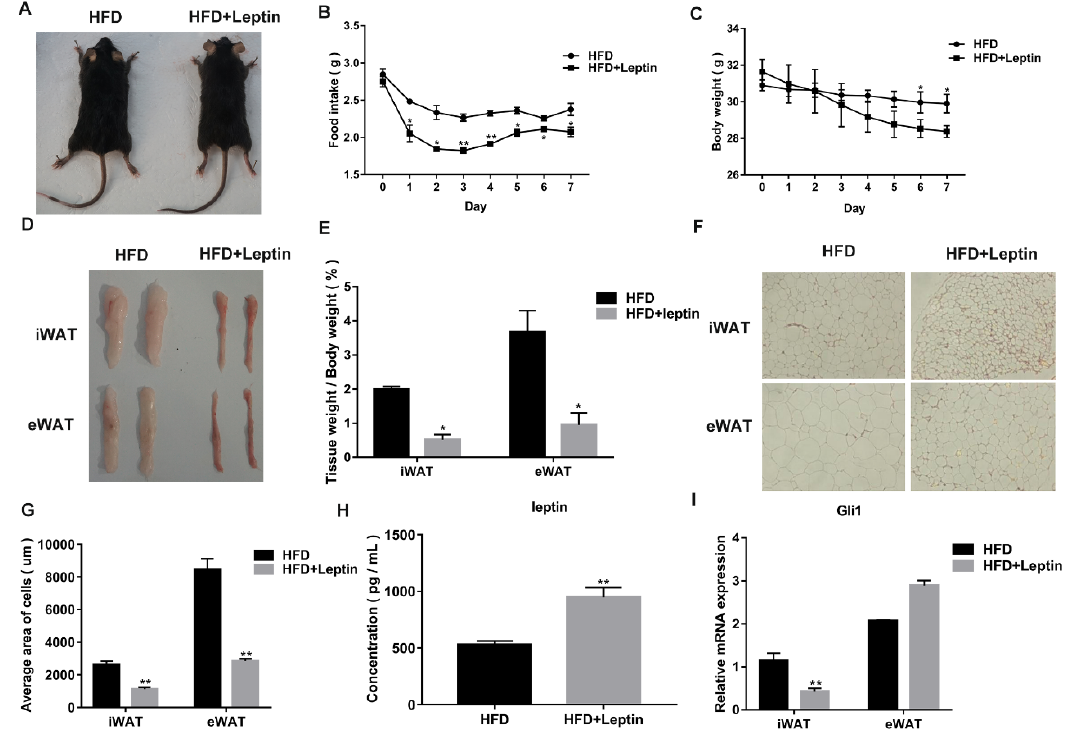
Figure 2. Leptin decreases food intake and adipose weight of high fat diet (HFD)-induced obese mice by inhibiting the Hh signaling pathway. ( A ) Representative image of HFD-fed mice injected with leptin recombinant protein or the control for seven days. ( B and C ) Daily food intake and body weight of the mice in the control and leptin recombinant protein injection groups (n = 4–6 per group). ( D ) Representative images of inguinal and epididymal white adipose tissue (iWAT and eWAT, respectively) injected with leptin recombinant protein or the control for seven days. ( E ) White adipose tissue masses were determined relative to body weight from HFD-fed mice injected with leptin recombinant protein or the control (n = 5). ( F ) Representative images of white adipose (iWAT and eWAT) stained with HE from HFD-fed mice injected with leptin recombinant protein or the control (n = 3). ( G ) Every adipose cell area in the eWAT and iWAT sections stained with HE in HFD-fed mice injected with leptin recombinant protein or the control (n = 3). ( H ) Serum leptin concentration was detected by ELIAS kit after injecting with leptin recombinant protein or the control (n = 5). ( I ) RT-qPCR was used to detect the expression level of the Hh signaling pathway marker gene Gli1 in eWAT and iWAT after injecting with leptin recombinant protein or the control. Scale bar = 20 µm. *, p < 0.05; **, p < 0.01.